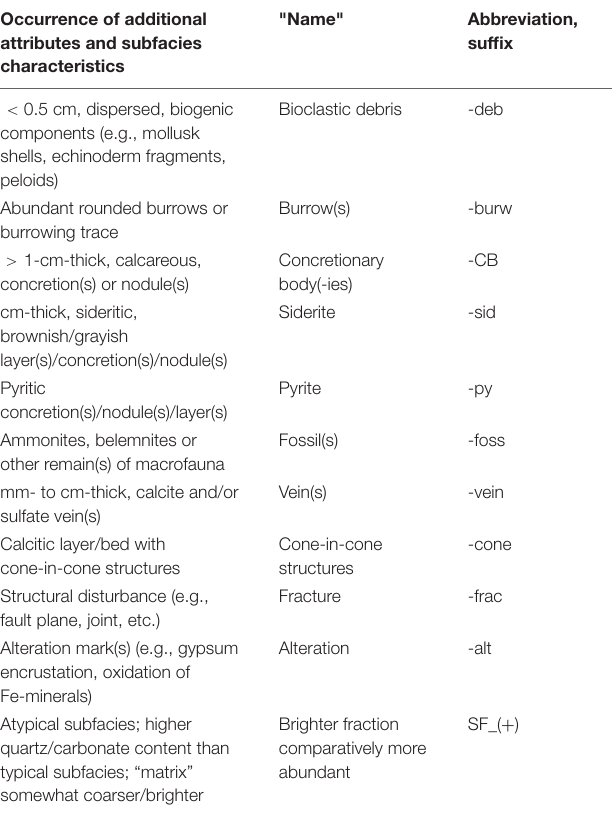
TABLE 2 | Extension of the subfacies classification scheme: abbreviations and suffixes highlighting the main additional features and lithological characteristics for refined subfacies